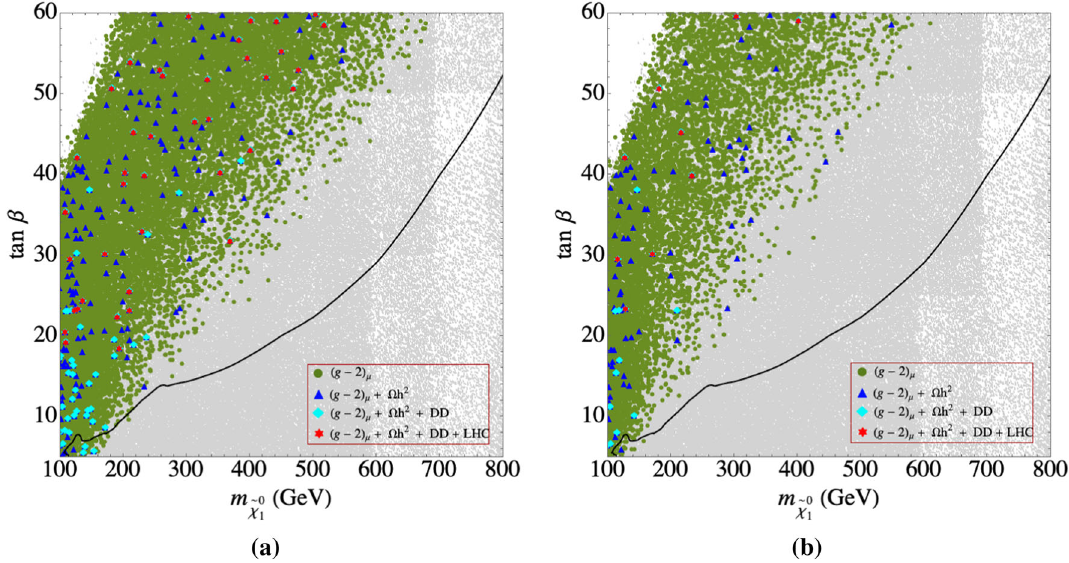
Fig. 15 The results of our parameter scan in the m ˜ χ 0 (right) from ( g − 2 ) μ ). The color coding is as in Fig.